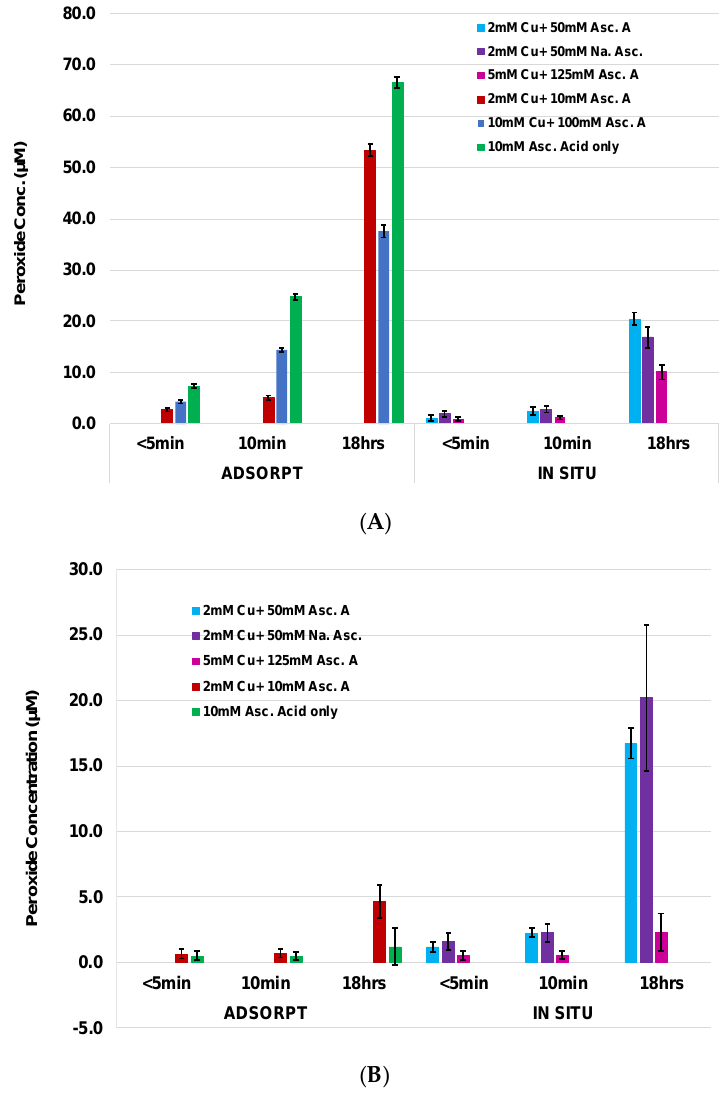
Figure 4. Peroxide generation of HE nonwoven greige cotton fabric determined by the Amplex Red assay, of adsorbed and in situ method treated samples ( A ) before and ( B ) after submersion in phosphate buffer pH 7.4 and blotted before assay, with the [AR] and [HRP] final concentration totaling 200 µM and 0.05 U/mL, respectively. Note: Untreated generated ~1.2 µM of peroxide.